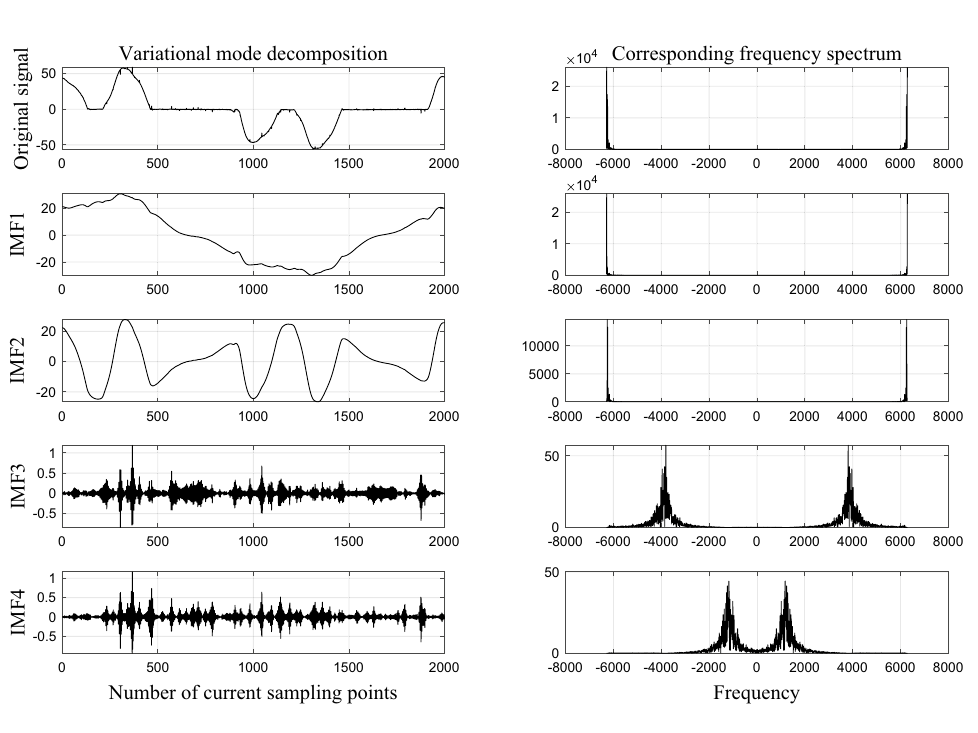
Figure 5. The result of VMD in fault